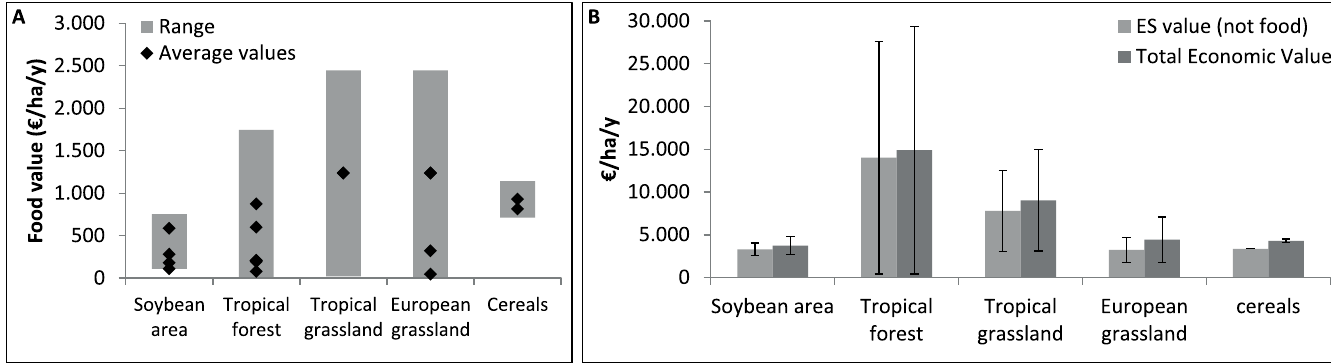
Fig 5. Total Economic Value per land use. A: Monetary value of food provisioning per land use, with indication of the value range (grey bar) and average values from literature (black diamonds). B: Monetary value of ecosystem services (excl. food provisioning) and total economic value per land use (including food provisioning). The error bars represent the minimum and maximum estimates based on the lowest and highest values found in literature.